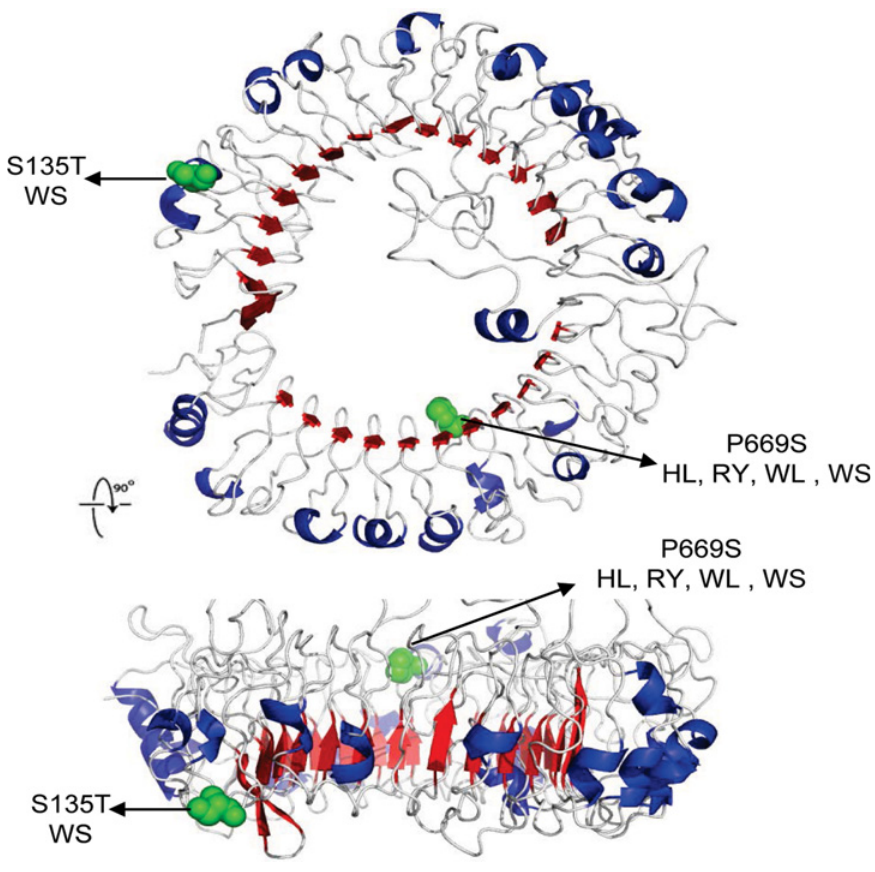
Fig 2. Visualization of amino acids corresponding to nonsynonymous single nucleotide polymorphism in extracellular domain of chicken TLR7 based on the protein structure predicted by CPHmodels 3.0 Server (www.cbs.dtu.dk). HL = Hy-Linevarietybrown chicken, RY = Royal chicken, WL = White Leghorn chicken, WS = White-Feather Silky